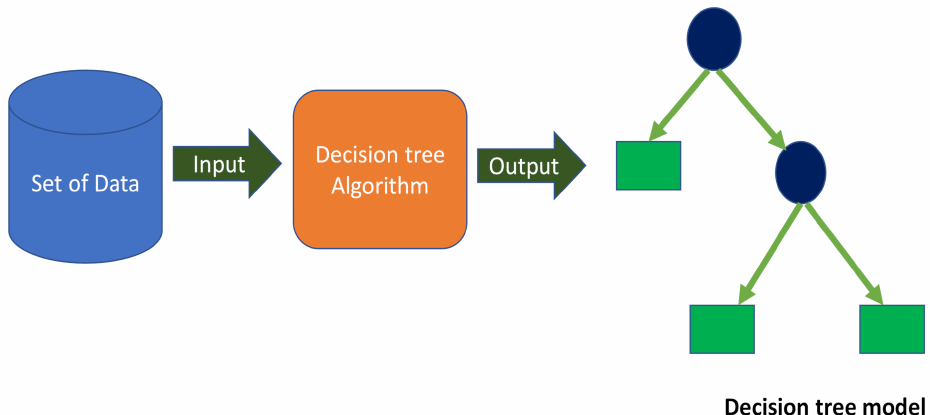
Figure 3. Decision tree schematic representation